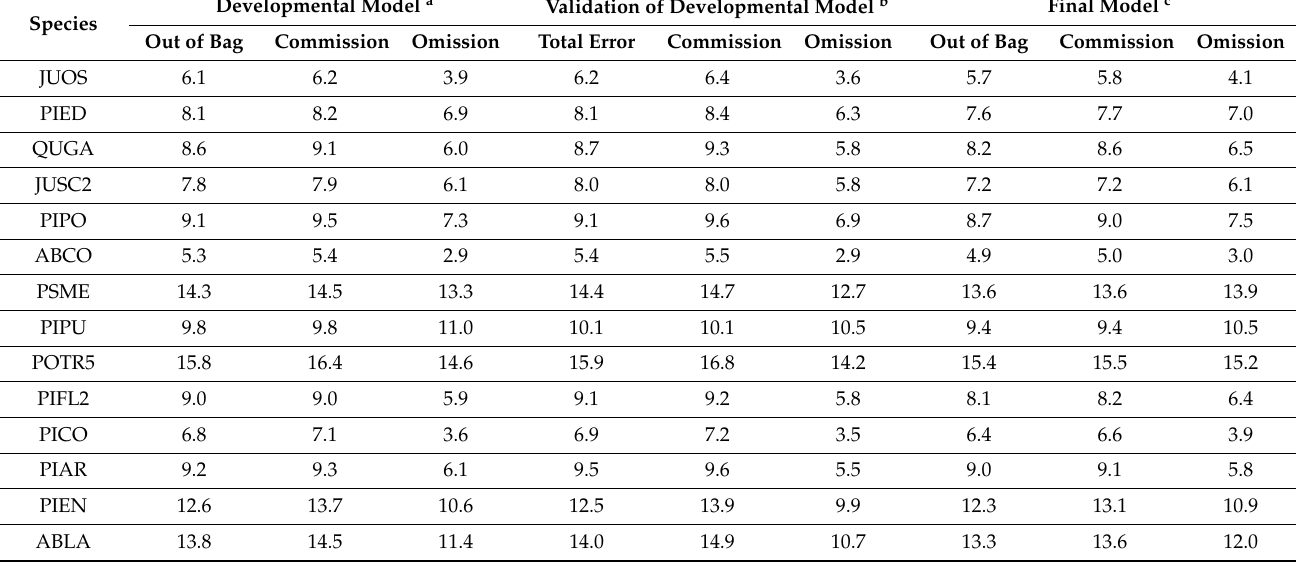
Table 4. Errors of fit (%) for the developmental models, validation exercises, and final